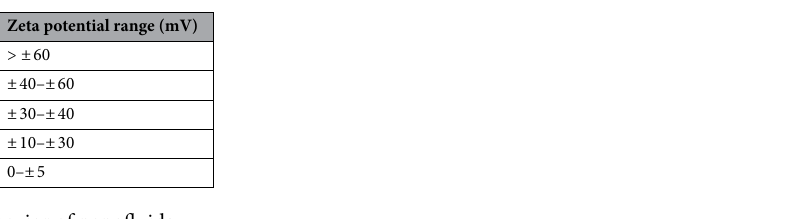
Table 1. Stability behavior of